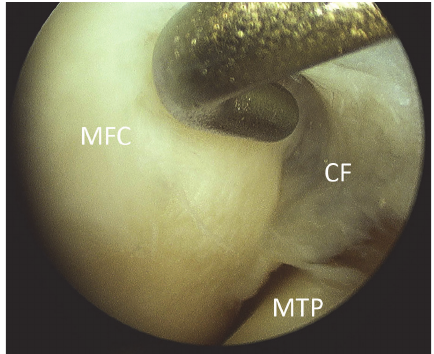
Figure 5: Arthroscopic view of the chondral flap. MFC: medial femoral condyle. CF: chondral flap. MTP: medial tibial plateau.